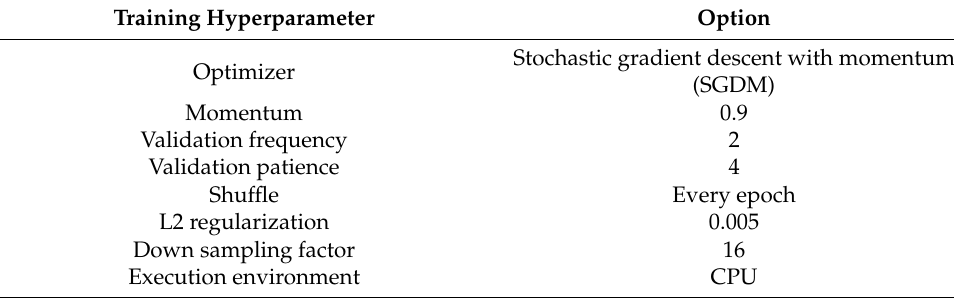
Table 9. Fixed training hyperparameters and their